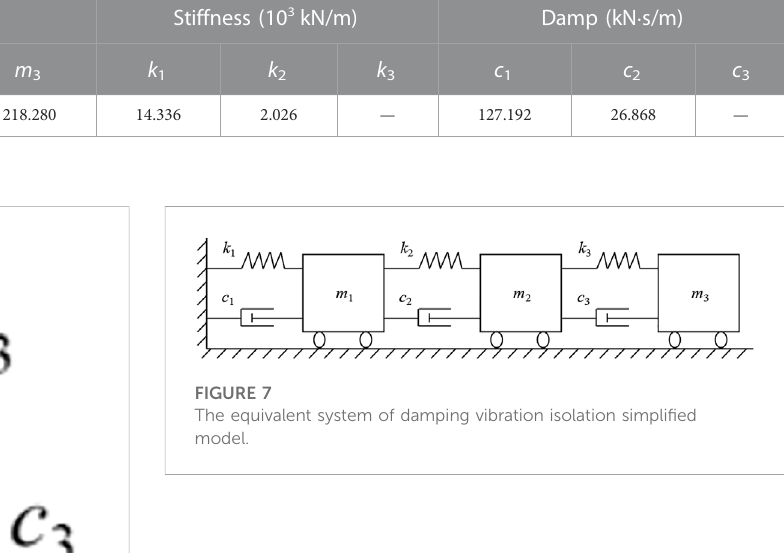
TABLE 2 The parameters of vibration isolation system simpli fi ed model. Parameter